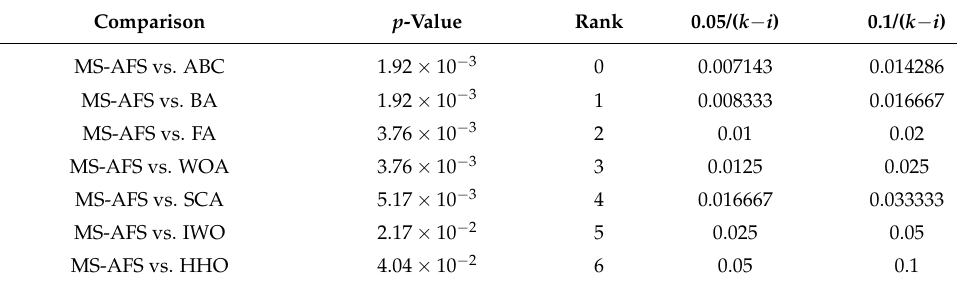
Table 9. Results of the Holm’s step-down